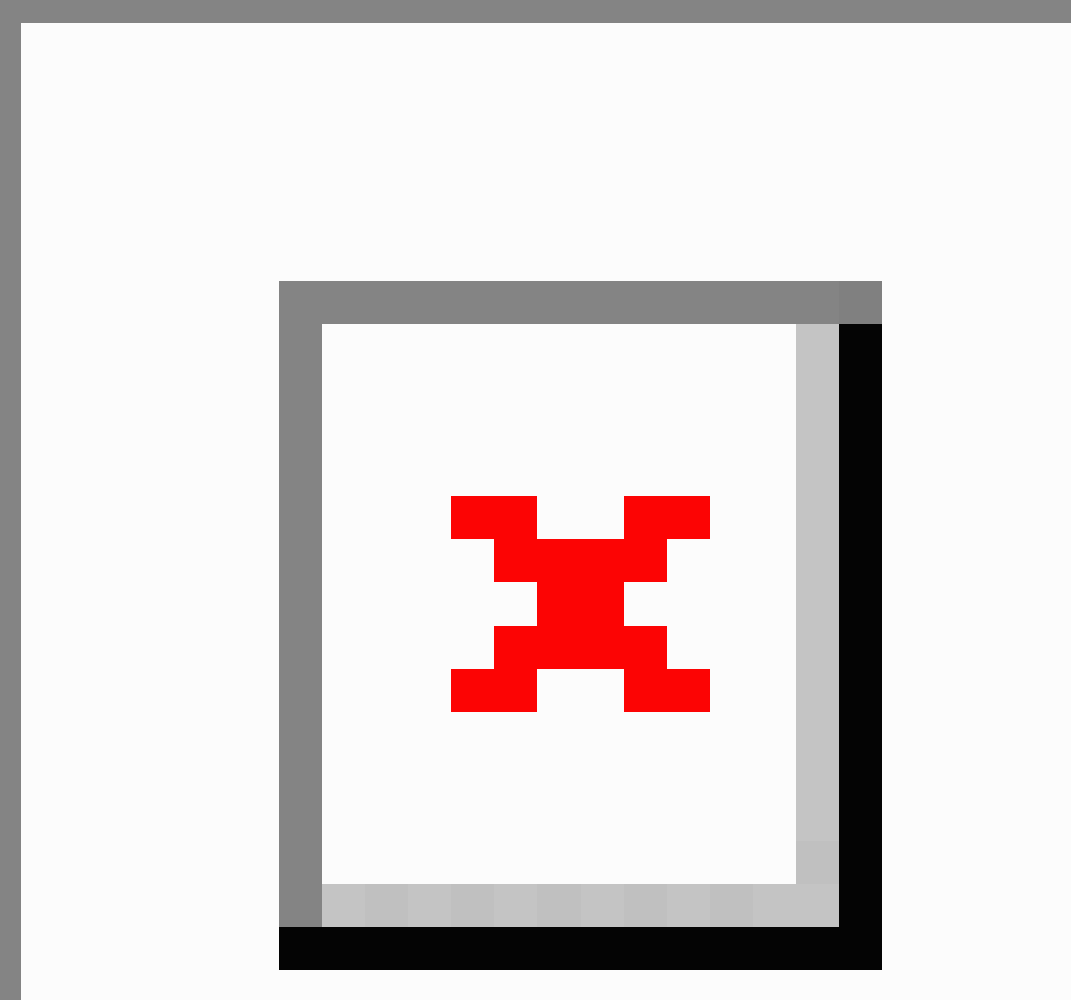
Figure 1. Eligibility, enrollment, random assignment, and assessment of study participants. BMI = body mass